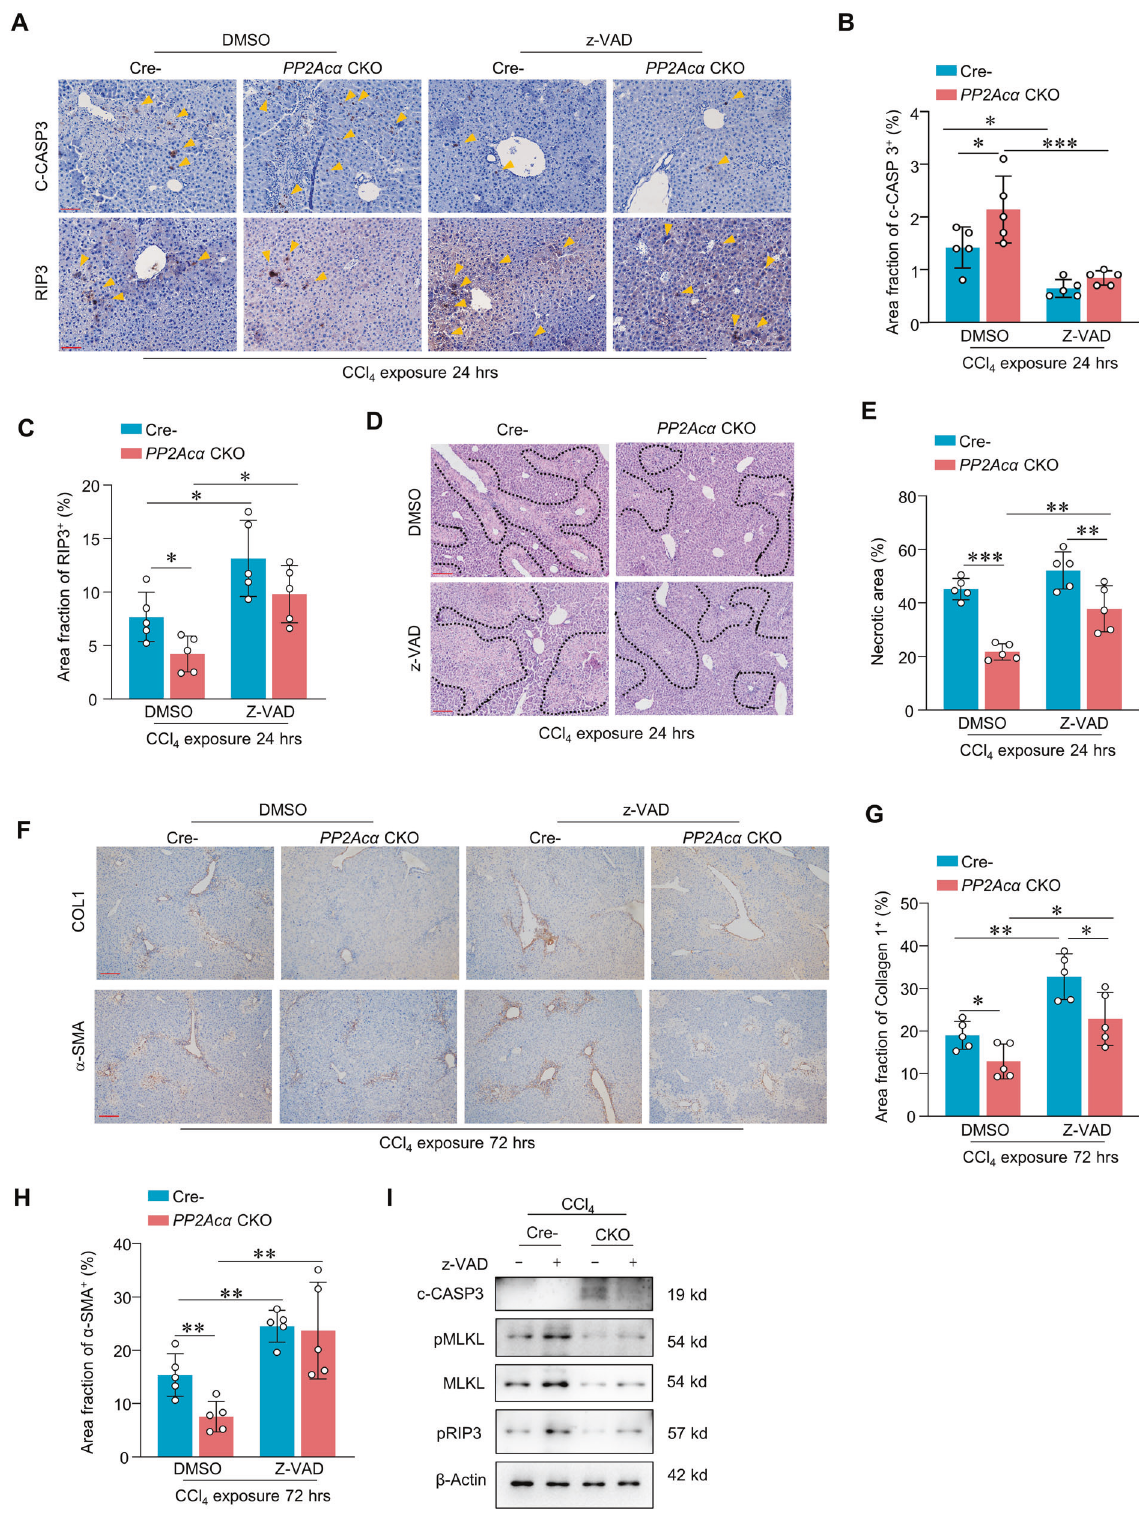
Fig. 6 Inhibiting apoptosis by z-vad-fmk increased the damage in ALI. Representative images of IHC staining of liver c-CASP3 and RIP3 ( A ) (scale bar, 100 mm) and quanti fi cation of liver c-CASP3-positive area ( B ) and RIP3-positive area ( C ) in Cre − and PP2Ac α CKO mice treated with z- vad-fmk 0.5 h, followed by CCl 4 24 h treatment ( n = 5) Representative images of H&E staining of liver ( D ) (scale bar, 200 mm) and quanti fi cation of liver necrotic areas ( E ) in mice treated as indicated ( n = 5). Representative images of IHC staining of liver Collagen I and α -SMA ( F ) (scale bar, 200 mm) and quanti fi cation of liver Collagen I-positive area ( G ) and α -SMA-positive area ( H ) in mice treated as indicated ( n = 5). I Immunoblotting showed the liver c-CASP3, pRIP3, pMLKL, and MLKL in Cre − or PP2Ac α CKO mice treated with z-vad-fmk 0.5 h, followed by CCl 4 24 h treatment.* p < 0.05, ** p < 0.01, *** p < 0.001, one-way ANOVA followed by Tukey ’ s multiple comparisons test ( B , C , E , G and H ). Data are represented as mean ± SD. Cell Death and Disease (2022)